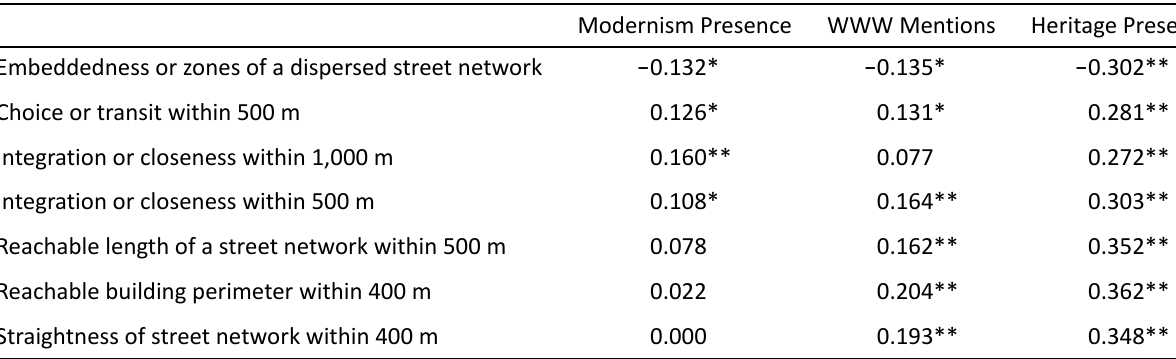
Table 2. Pearson correlations in space